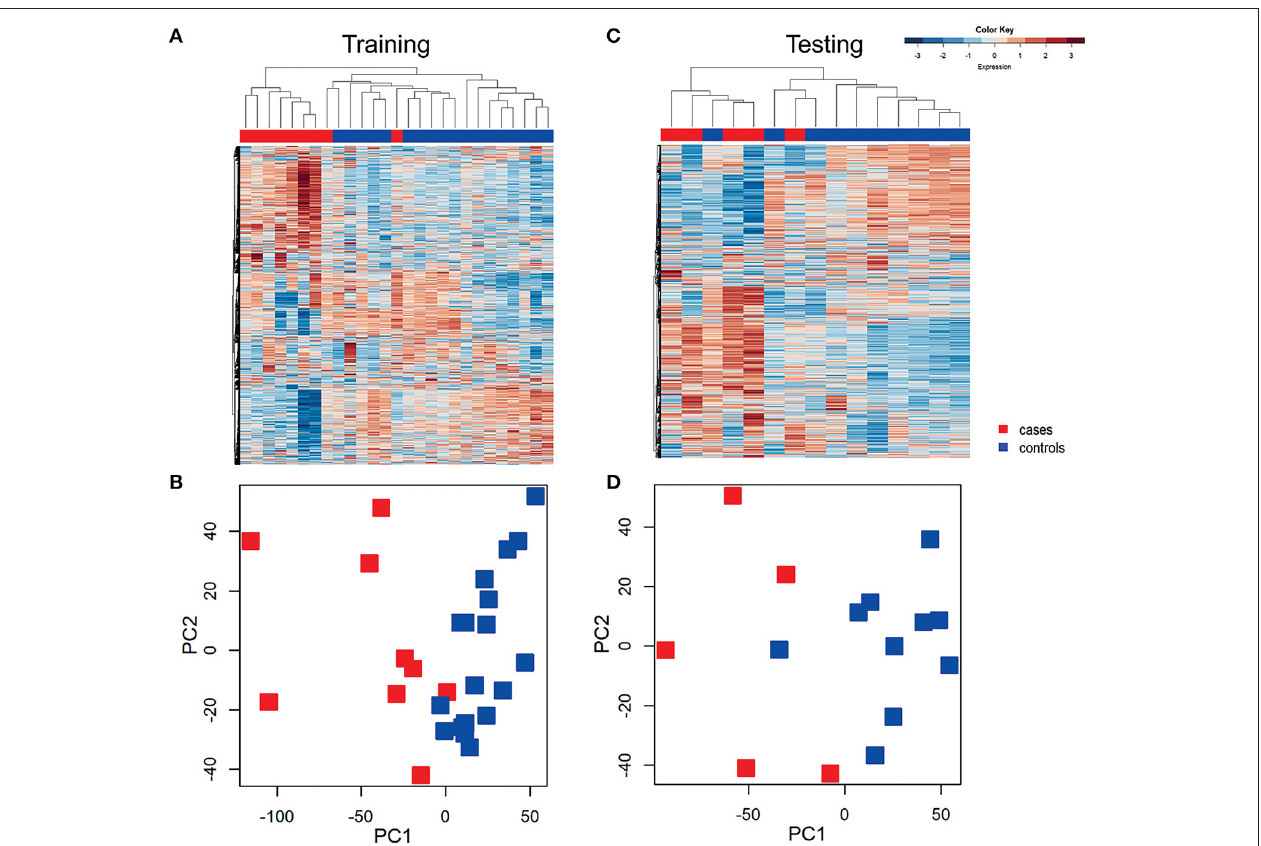
FIGURE 2 | Unsupervised hierarchical clustering and principal component analysis (PCA) revealed distinctive blood mRNA transcriptional profiles separating cases from controls. Unsupervised hierarchical clustering of blood transcriptional profiles of women in training (A) and testing (B) datasets using 4952 transcripts. Samples were ordered by hierarchical clustering (Spearman correlation with average linkage) creating a condition tree, upper horizontal edge of heat map; study groupings (clinical phenotypes) are the colored blocks on the top of each profile. Heat map rows are genes; columns are participants. Principle component analysis of the variance in mRNA expression of the subjects depicted in the heat maps in training (C) and testing (D) datasets, using 4,952 transcripts and the same color scheme with each colored square depicting one subject. The x axis represents the first principal component, PC1, which accounts for the largest variance of mRNA expression, and the y axis, PC2, explains the second largest variance.